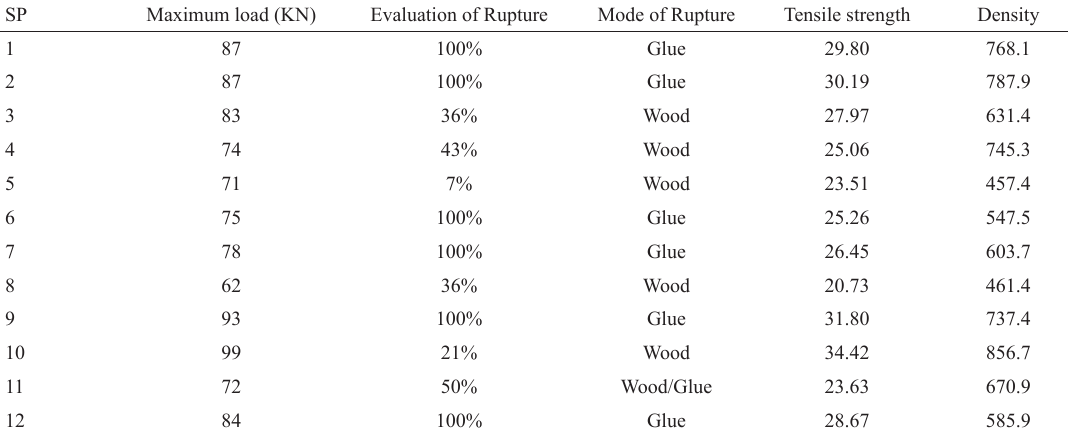
SP Maximum load